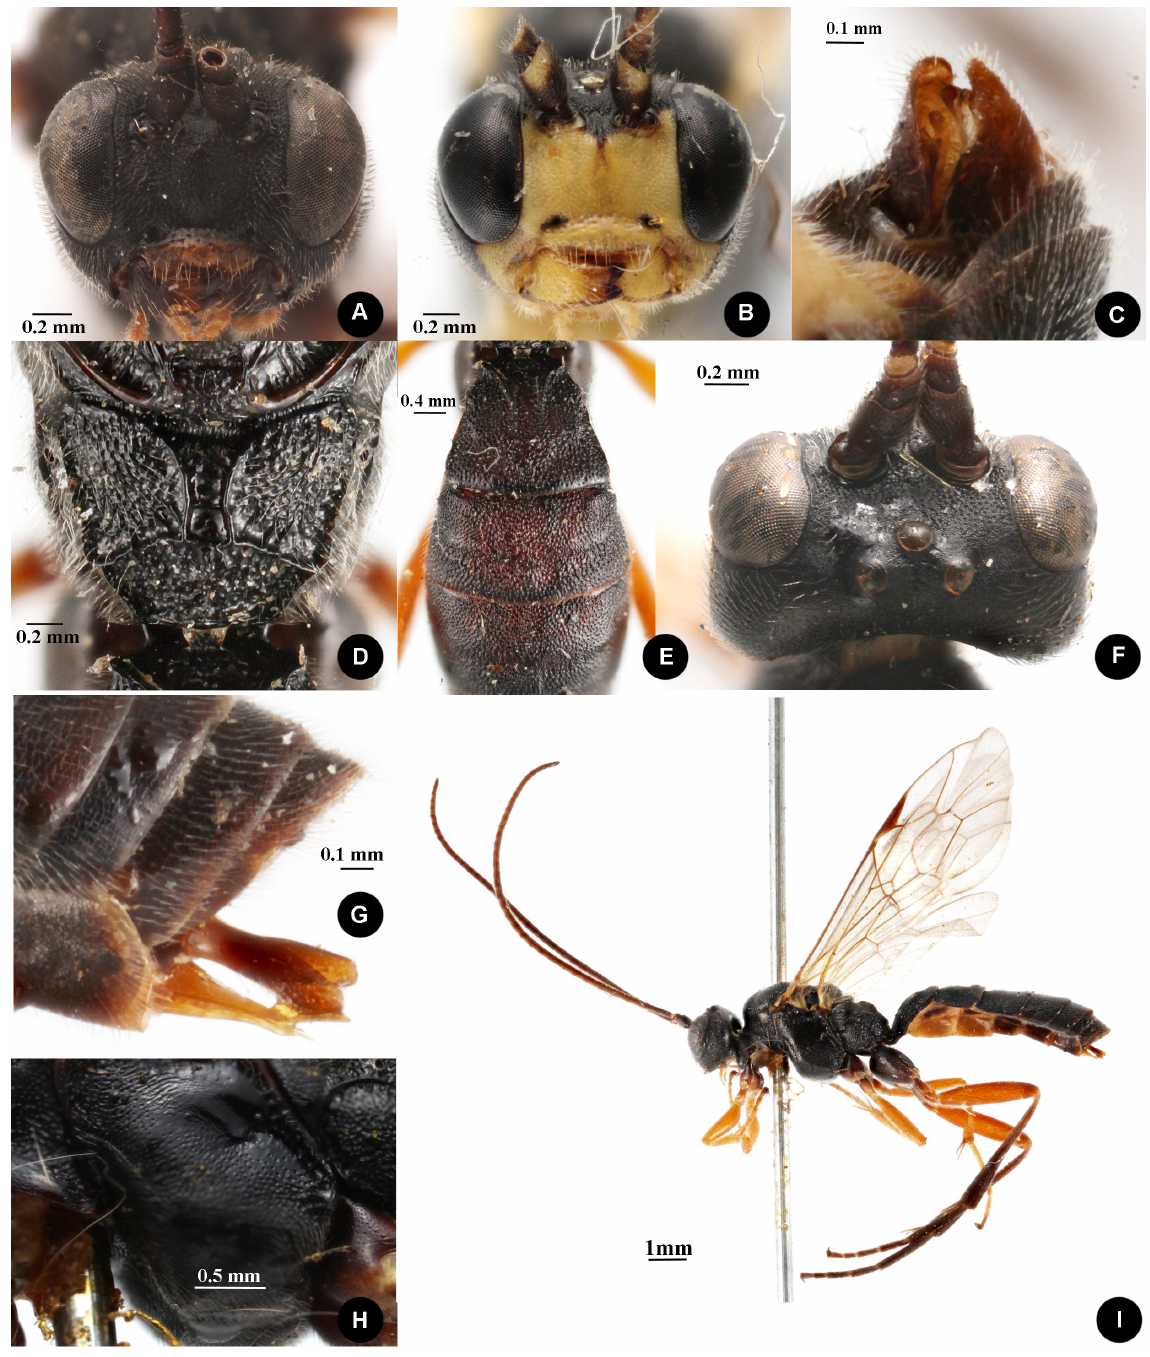
Fig. 5. Rhinotorus compactor (Thumberg, 1822). A . ♀ face. B . ♂ face. C . ♂ genitalia. D . Propodeum. E . Metasoma dorsally. F . Head dorsally. G . Ovipositor. H . Mesopleuron. I .